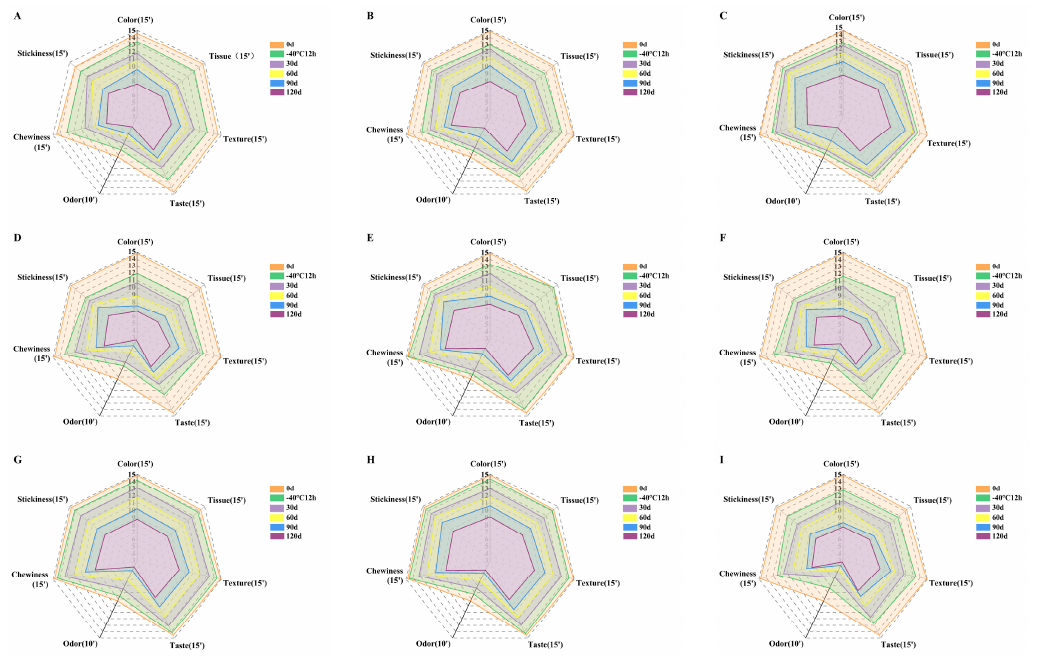
Figure 4. The sensory evaluation score of steamed bum made from un-fermented frozen dough with yeast dosage of 0.5% ( A ), 1.0% ( B ) and 2.0% ( C ), the pre-fermented time of 20 ( D ), 30 ( E ) and 40 min ( F ), and pre-steamed time of 10 ( G ), 15 ( H ) and 20 min ( I ). The scores in the brackets are the maximum scores for each sensory attribute.